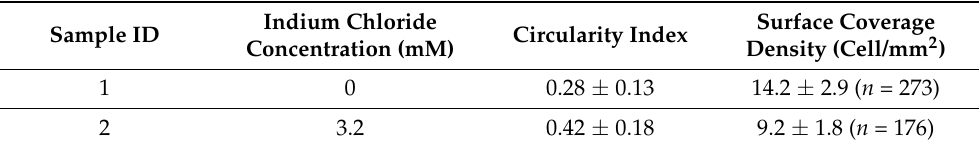
Figure 2. Fluorescence confocal micrographs of adherent cells in petri dish prepared with ( a ) indium-free media and ( b ) media containing 3.2 mM of InCl 3 . Images show cell density decreases after they are exposed to indium chloride. Cells also become more compact and circular in shape. DNA molecules are visualized with DAPI in blue; actin filaments are stained with deep red Cytopainter F-Actin. Table 1. Adherent cell coverage density and circularity index of cells incubated in culture medium that is indium-free or contains 3.2 mM indium chloride. Data spread corresponds to one standard